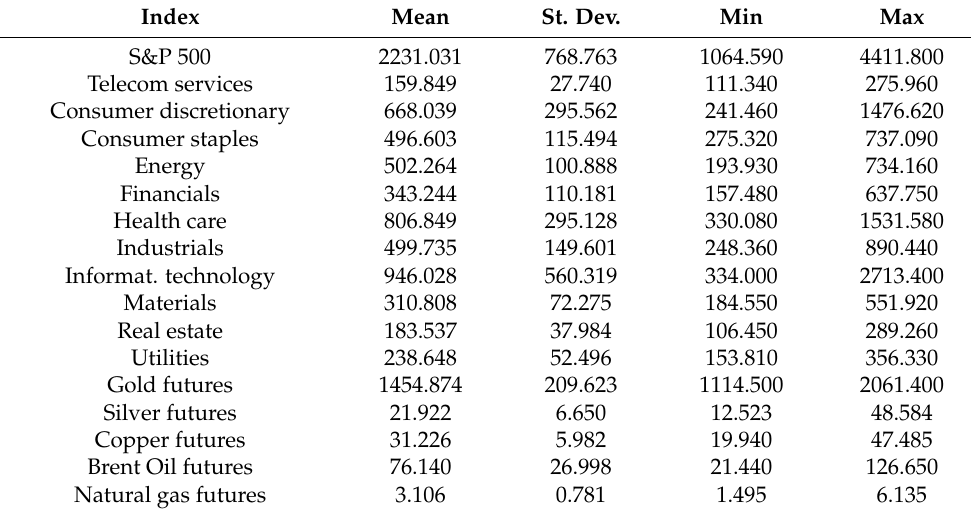
Table 1. Summary statistics of weekly closing